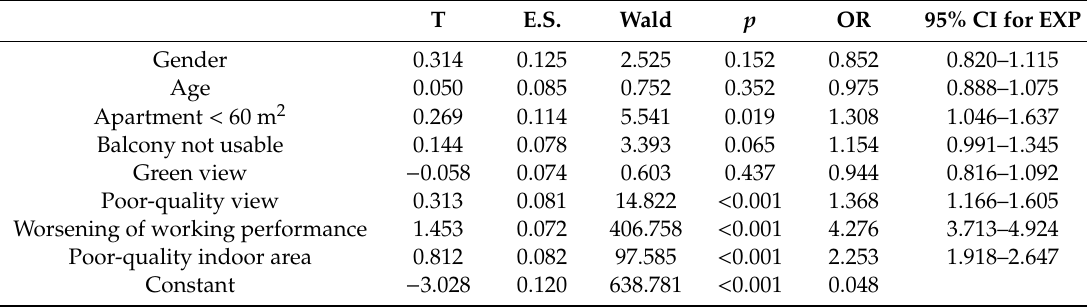
Table 4. Relationship between potential explanatory variables and moderate–severe depressive symptomatology: results from the stepwise logistic regression